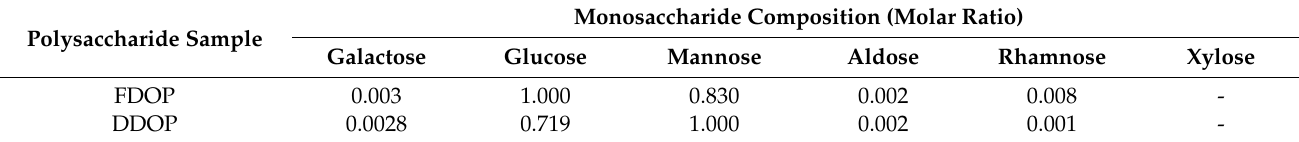
Table 2. Monosaccharide composition analysis of the FDOP and DDOP.